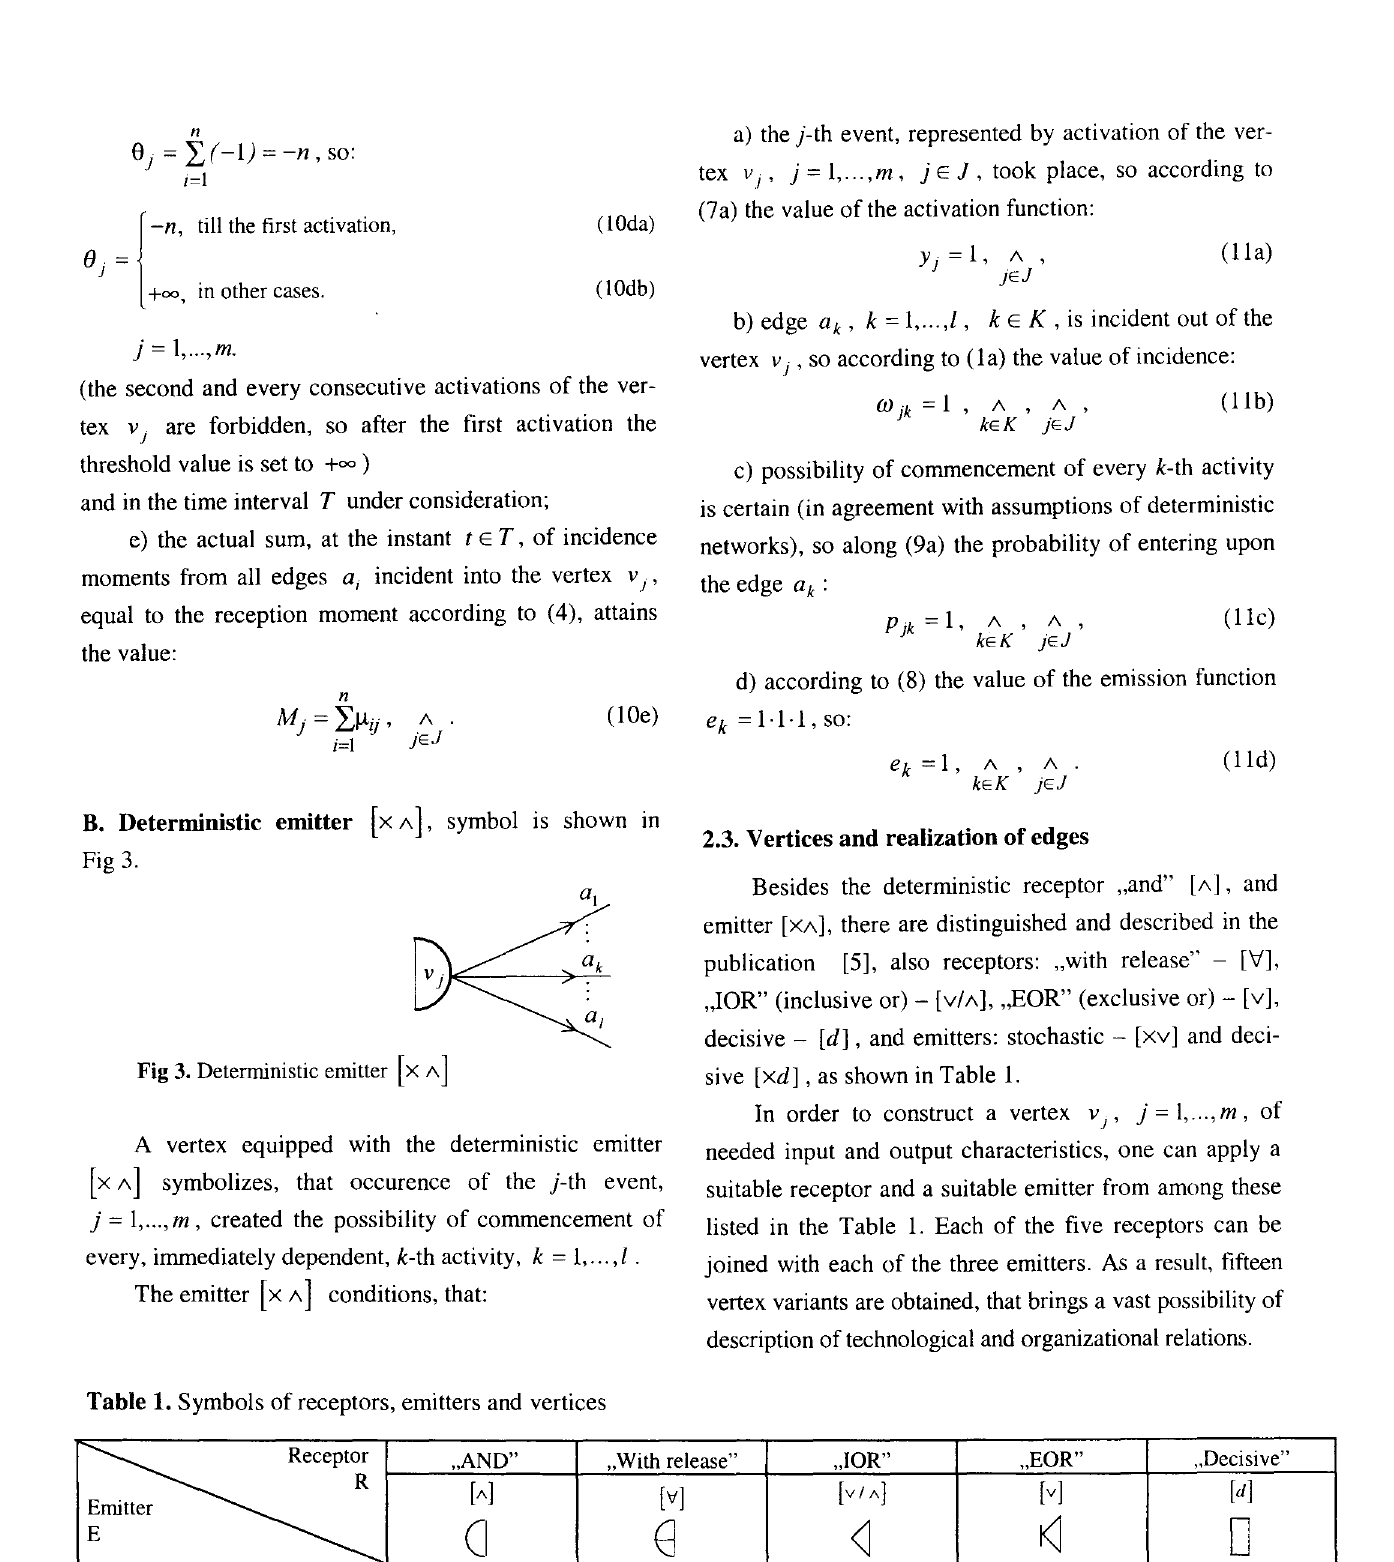
Table 1. Symbols of receptors, emitters and